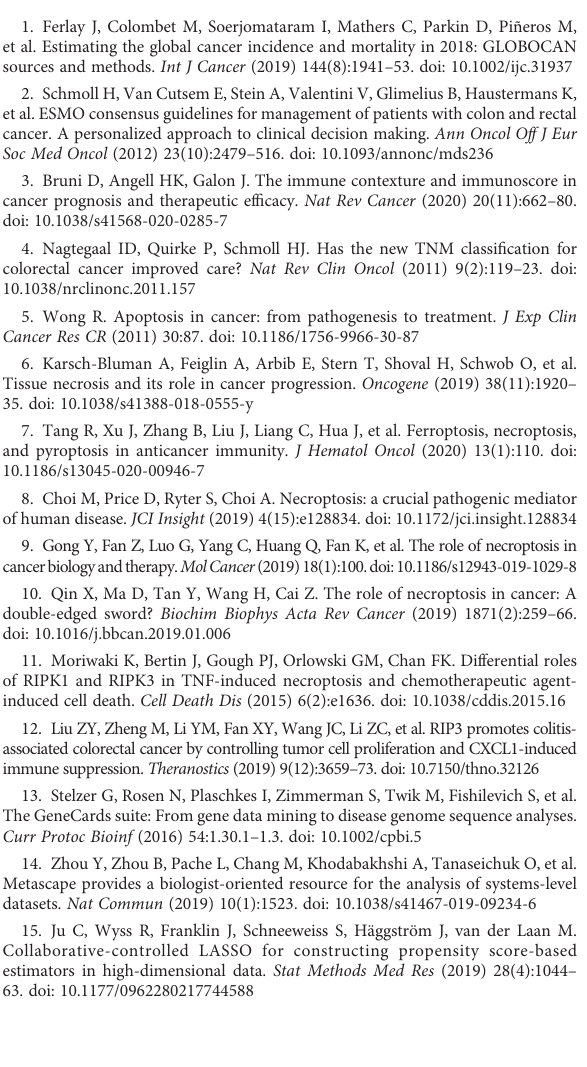
SUPPLEMENTARY DATA SHEET S2 Primers sequences used in qRT-PCR in our study.